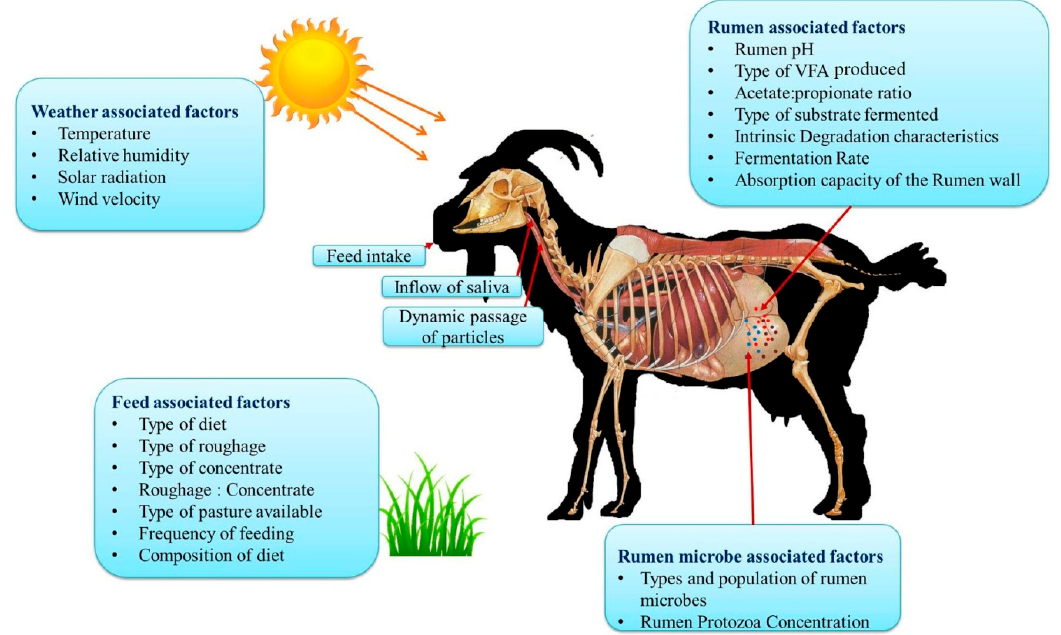
Figure 2. Various factors influencing enteric methane emission in goats (these concepts were adopted from References [8,28,29]).